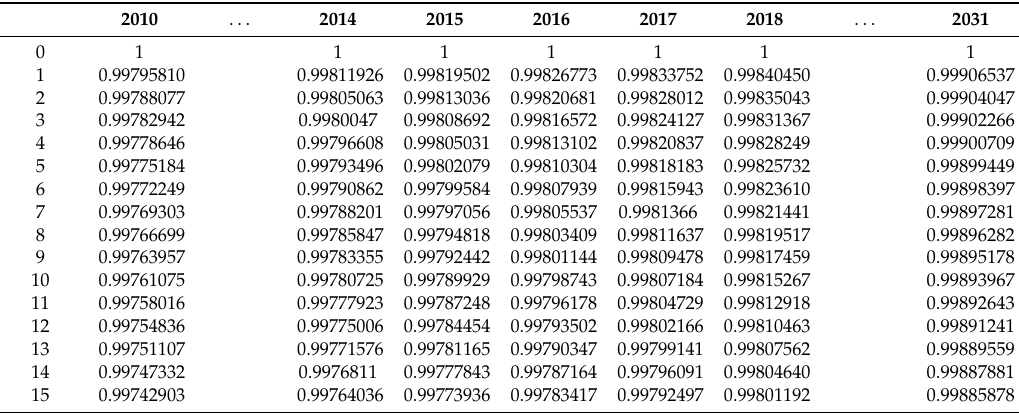
Table A1. Survival probability forecasting p x , U.K.